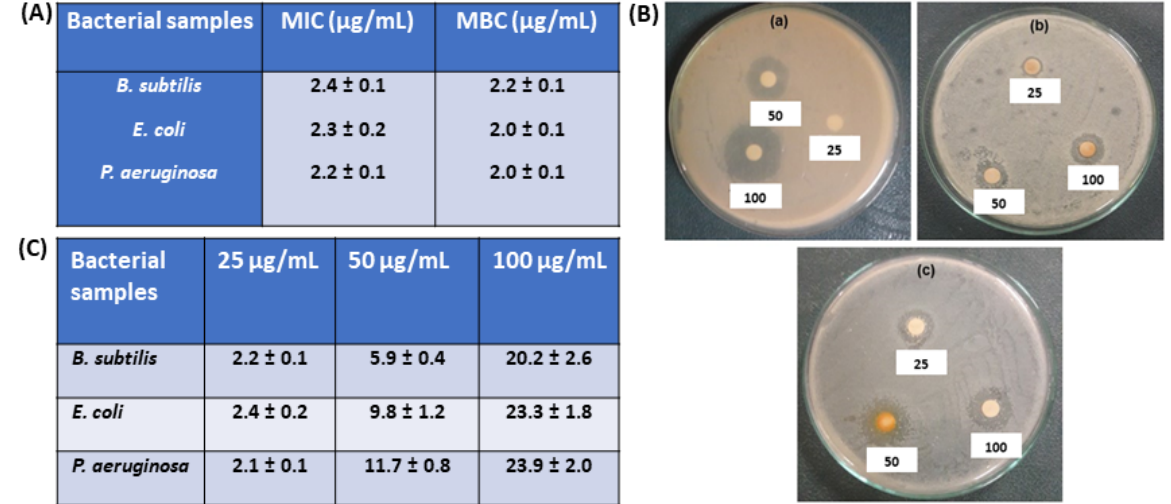
Figure 4. ( A ) MIC and MBC values of hybrid nanocomposite, ( B a–c) antibacterial activity on different concentrations of hybrid nanocomposite against tested ( B a) P. aeruginosa, ( B b) B. subtilis, and ( B c) E. coli . bacterial pathogens, and ( C ) the calculated ZoI values. The MIC, MBC, and ZoI values are presented as mean ± SD.